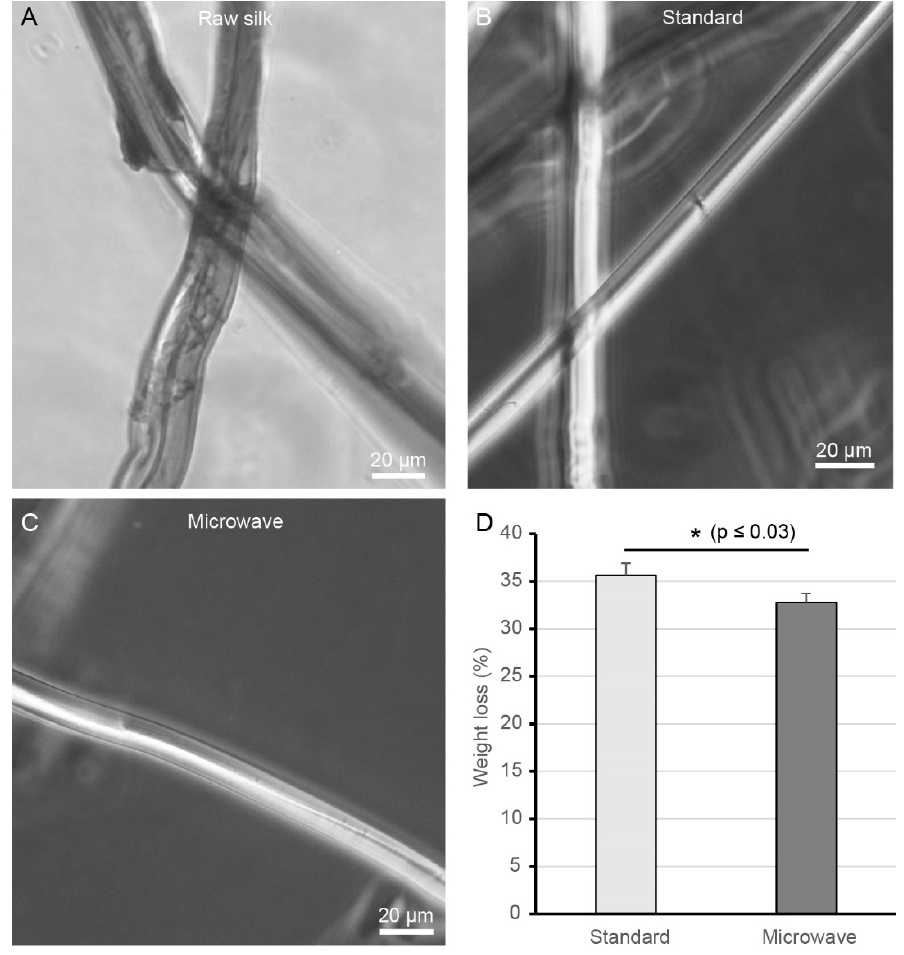
Figure 1. Light microscopic images of silk fibroin samples: ( A ) Raw silk fibers consist of two silk fibroin fibers covered and glued by a layer of sericin. ( B ) Silk fibroin fibers after standard degumming (30 min boiling in 0.02 M Na 2 CO 3 ) and ( C ) microwave degumming. The scale bar corresponds to 20 µm. ( D ) Mean weight loss after degumming. The weight loss after degumming is expressed as the mean of four independent experiments ± standard error of the mean (SEM).